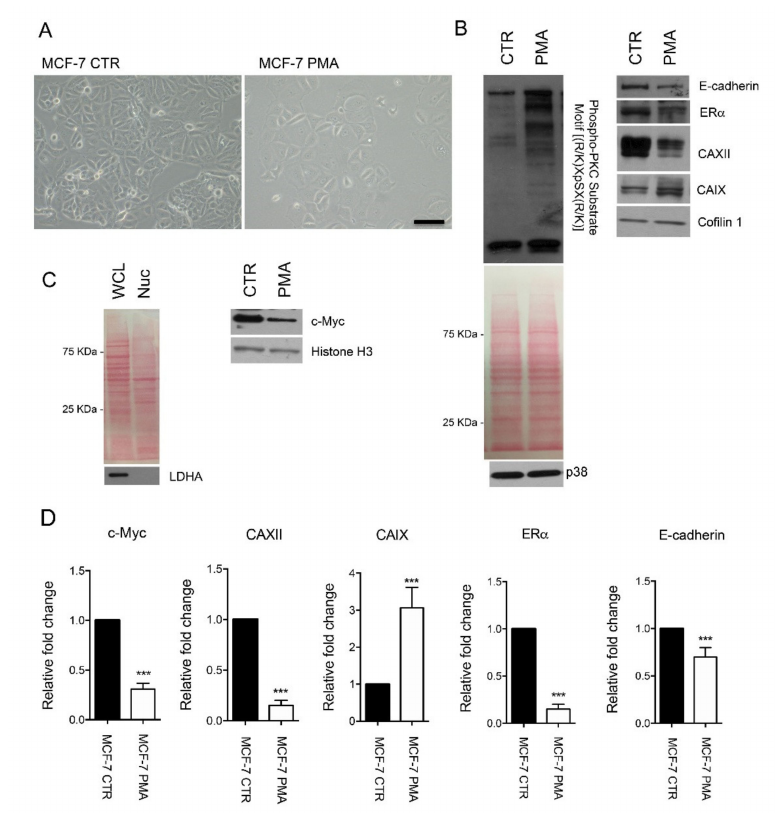
Figure 5. Protein kinase C (PKC) activation in MCF-7 cells induces changes in the expression of EMT markers and CAXII. ( A ) Representative images of MCF-7 cells treated with vehicle (DMSO) or phorbol ester 12-myristate 13-acetate (PMA) at the concentration of 100 nM for 48 h. Images were acquired using an inverted wide-field microscope (Olympus IX51). Scale bar 100 uM. ( B ) Cells were then harvested, and cell lysates were subjected to western blot using anti-phospho-PKC substrate motif [(R / K)XpSX(R / K)], anti-E-cadherin, anti-ER α , anti-CAIX, anti-CAXII antibodies. Anti-Cofilin 1 and anti-p38 were used as loading controls. ( C ) Whole cell lysate (WCL) and nuclear (Nuc) proteins were separated by SDS-PAGE and transferred to nitrocellulose membrane. Blots stained for WCL and Nuc proteins with Ponceau S are showed. Western blot showing L-lactate dehydrogenase A chain (LDHA) expression in WCL and Nuc fractions was used as cytosolic marker. Western blot analysis of c-Myc expression in the Nuc fraction of MCF-7 treated or not with PMA. Anti-Histone 3 was used as loading control. ( D ) Band density was measured using ImageJ. p -value *** < 0.001 by t